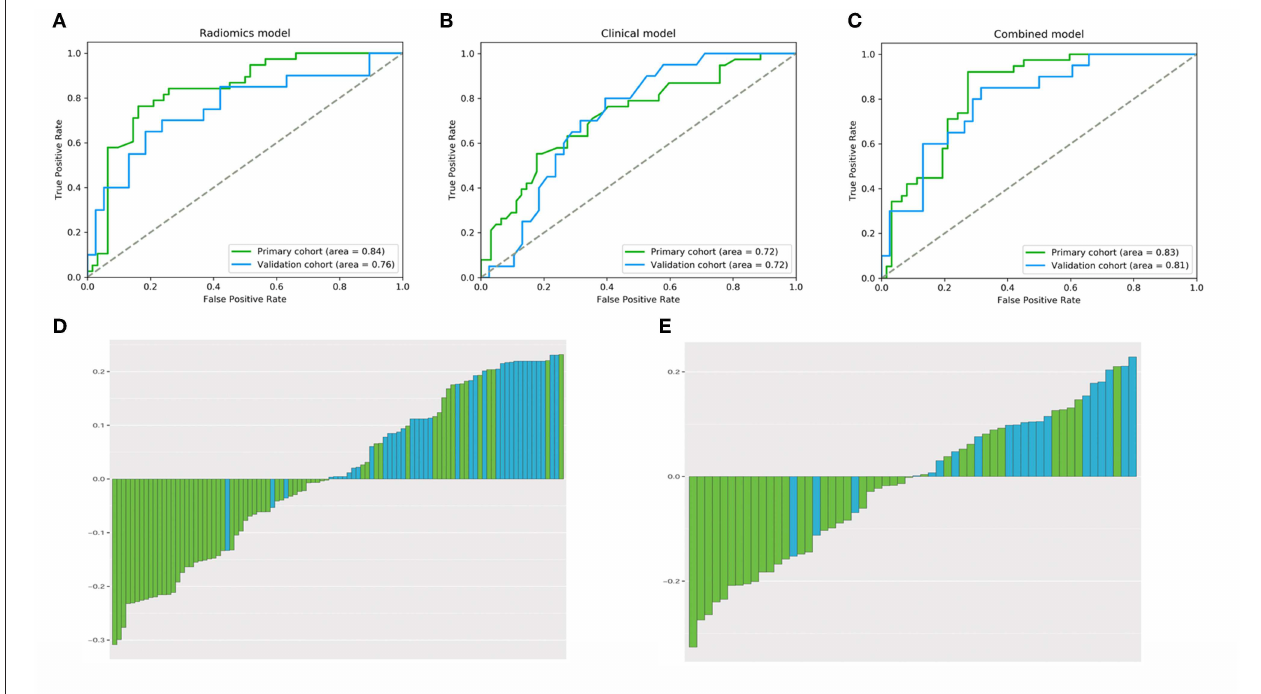
FIGURE 4 | The performance of (A–C) ROC curves for the three models and (D,E) bar plots for the radiomics model in the primary and validation cohorts. The performance of the models was assessed using the AUC. (A) Radiomics signature. (B) Clinical model. (C) Radiomics model. (D) Primary cohort. (E) Validation cohort.